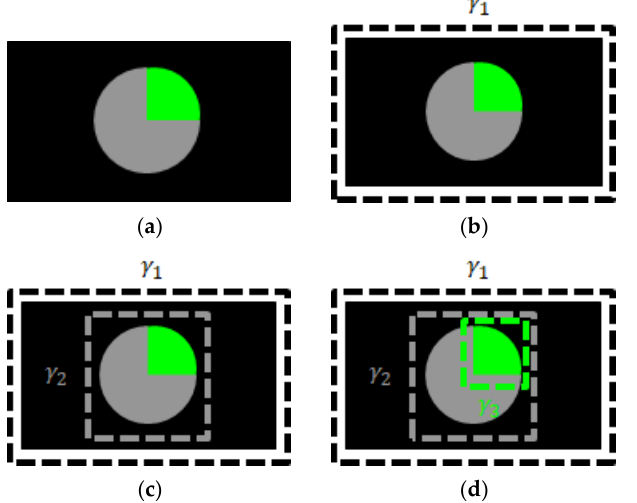
Figure 3. Low power saliency methods. ( a ) Original image; ( b ) global dimming; ( c ) saliency-aware method; ( d ) proposed method.